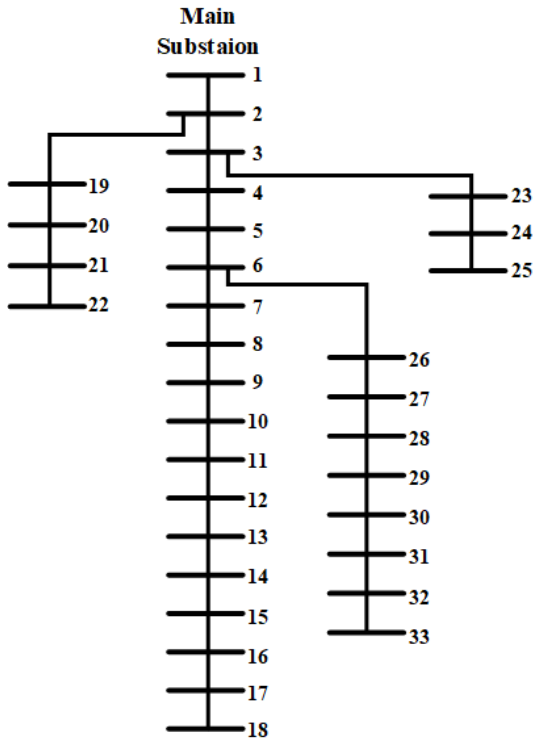
Figure 4. IEEE 33-bus